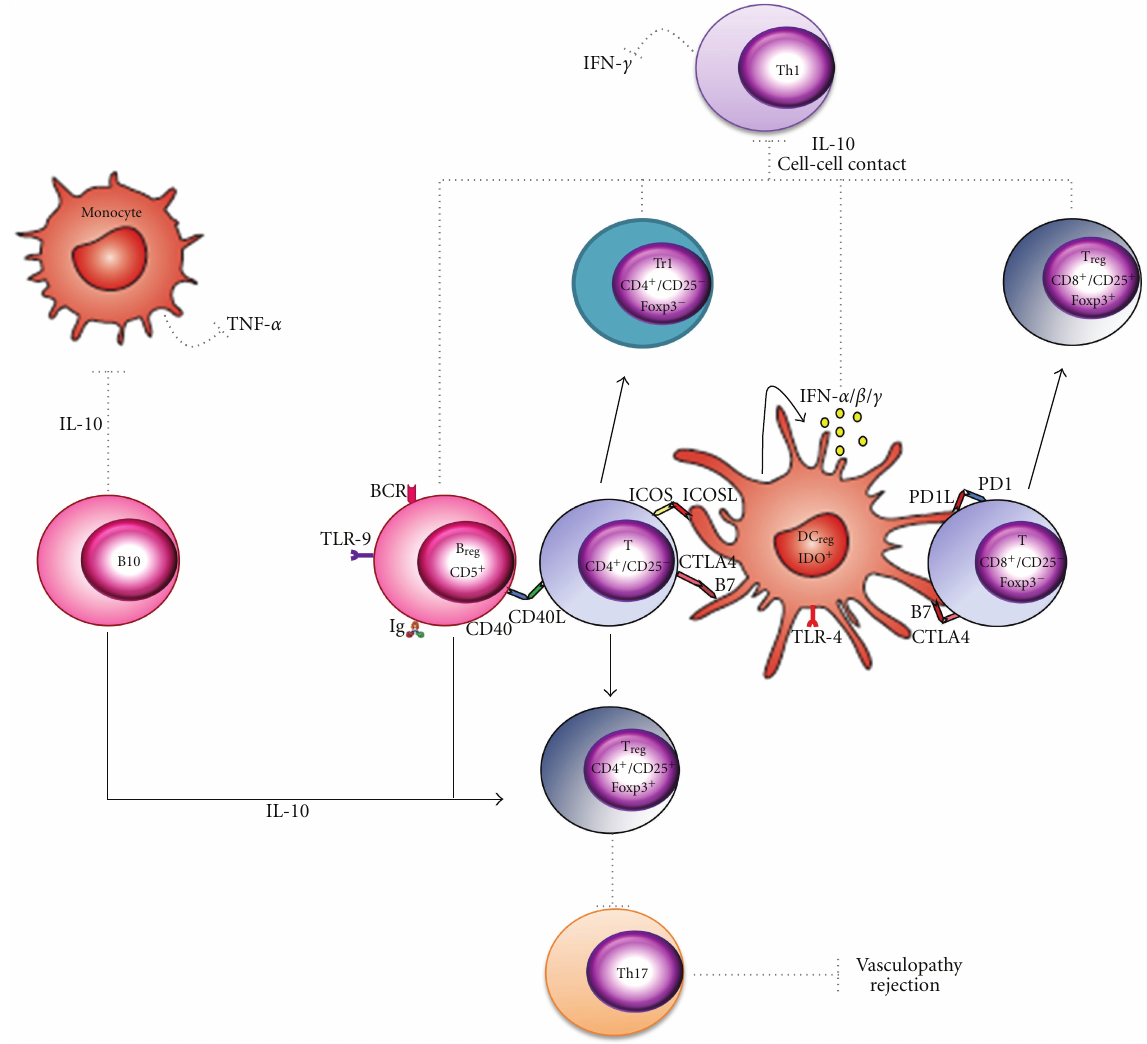
Figure 5: Hypothetical model by which Bregs, Tregs, and DCregs generate a positive feedback in a three-way loop. IL-10—producing Breg cells favor the di ff erentiation of CD4 + /CD25 − T cells into CD4 + /CD25 + Foxp3-expressing T cells or CD4 + /CD25 + /Foxp3 − T cells after stimulation through CD40/CD40L or B7.1,B7.2/CTLA-4, respectively, in presence of IL-10. IL-10 induces phosphorylation of STAT3 (pSTAT3) in Foxp3—expressing CD4 + and CD8 + Tregs, Tr1 and DCs. Tregs with pSTAT3 are capable of suppressing Th17 responses or activation of STAT1 and induce/upregulate IDO activity in DCs through mechanisms requiring CTLA-4 expression, whereas Tr1 suppresses Th1 response and IFN- γ production by cell-cell contact and/or IL-10 production. On the other hand, pSTAT3 in DCs induces downregulation of antigen presenting cell function (CD40, CD80, CD86, MHC I, and HLA-DR expression). Moreover, activated DCs by IFN- α / β / γ express IDO after B7.1/B7.2 ligation to CTLA-4. IDO-expressing DC cells, as Bregs, contribute to regulatory T cell generation (CD4 + /CD25 + /Foxp3 + ) from CD4 + /CD25 − T cells through ICOSL-ICOS interaction. Meanwhile, IDO-expressing DC cells contribute to di ff erentiate CD8 + /CD25 + /Foxp3 + Tregs from CD8 + /CD25 − T cells through PD1-PDL1/2 interaction. CD19 + /CD24 hi /CD38 hi /CD27 + B10 cells suppress TNF- α production by monocytes, via IL-10